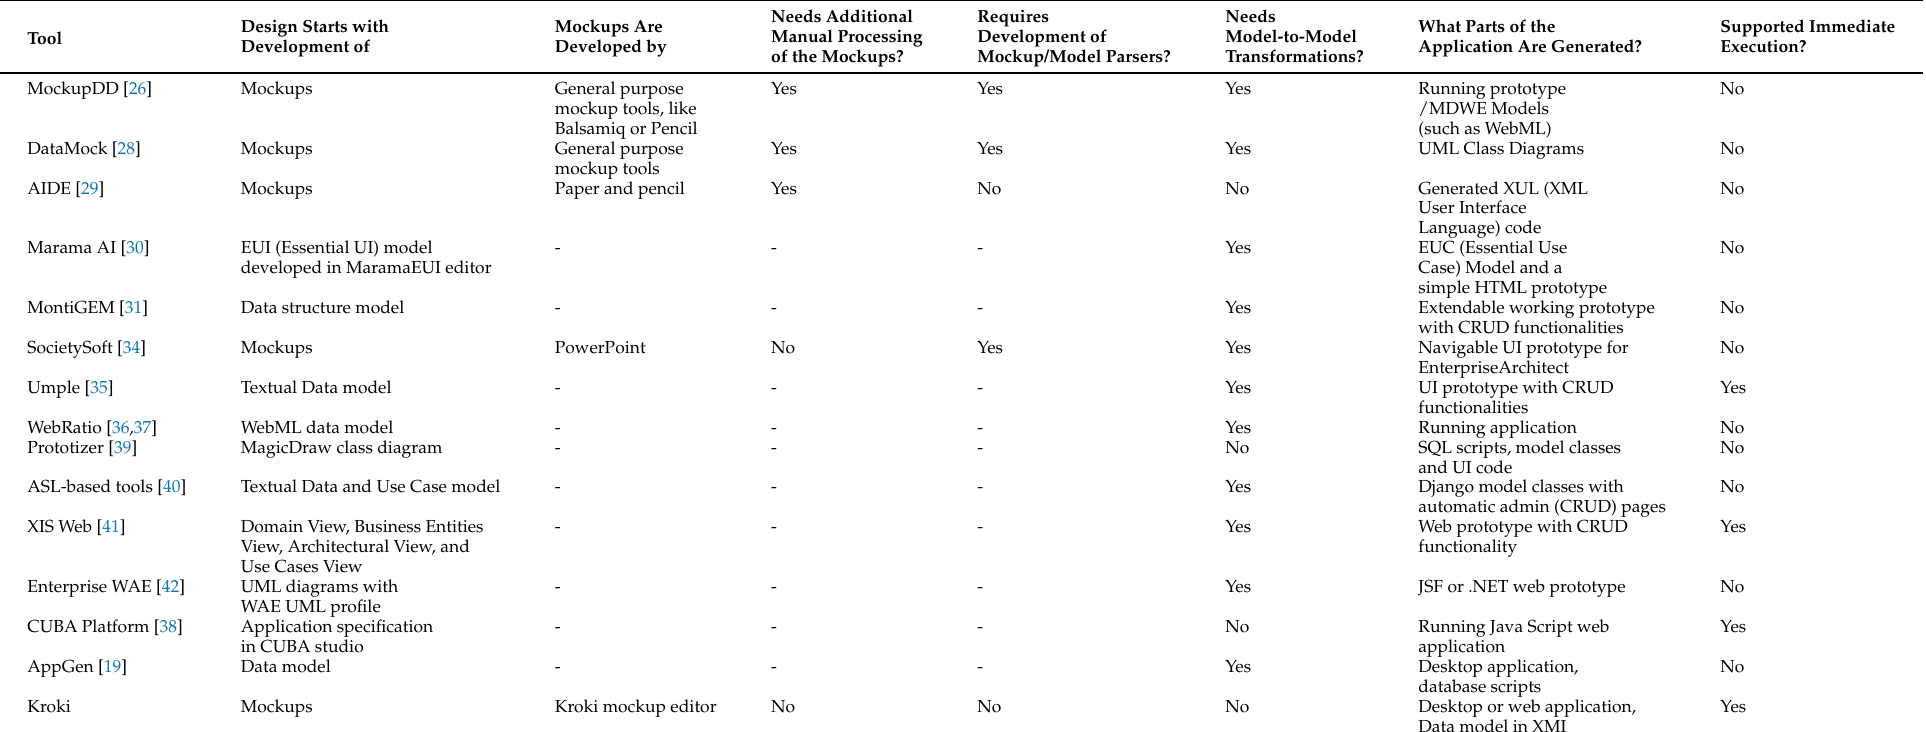
Table 9. Comparison of mockup